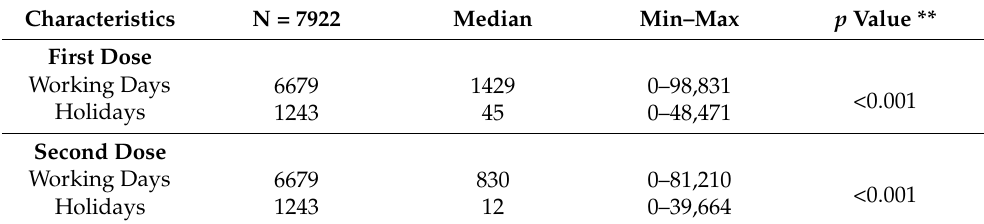
Table 4. Statistical analysis of vaccination data based on day type.